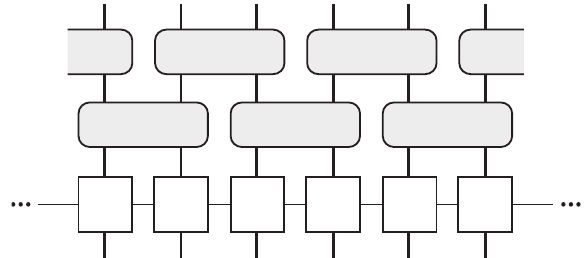
FIG. 11. “ Dressing ” of a base MPU with a known chiral unitary index. The lowest layer (unshaded) represents a base MPU constructed by taking copies of the translation operators. The upper layers (shaded) represent a simple FDLU. Each shaded box corresponds to a different random unitary operator, so the system is